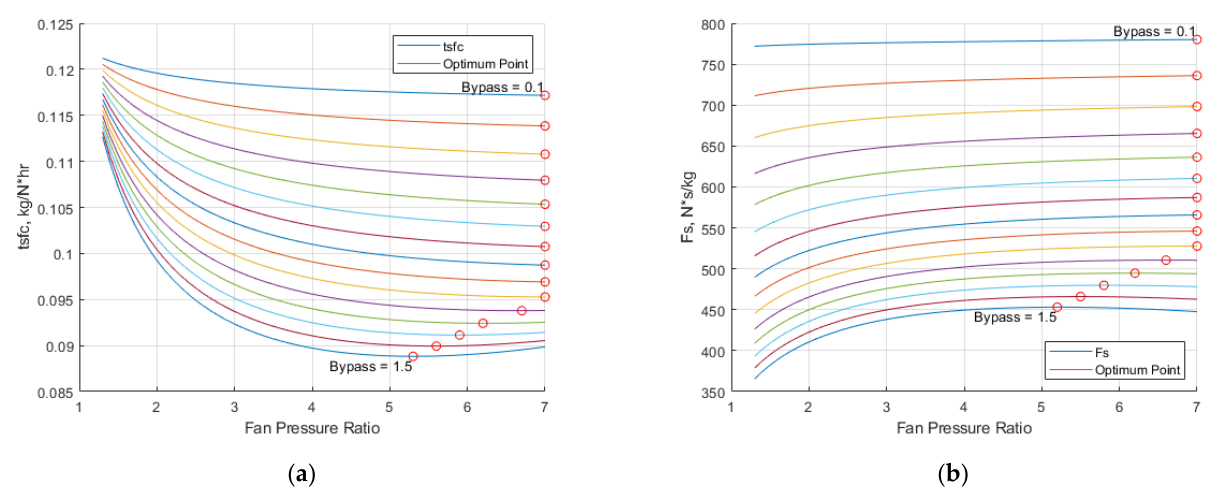
Figure 2. Plots of the optimum FPR with BPR increasing with each line for ( a ) minimizing TSFC and ( b ) maximizing Fs .